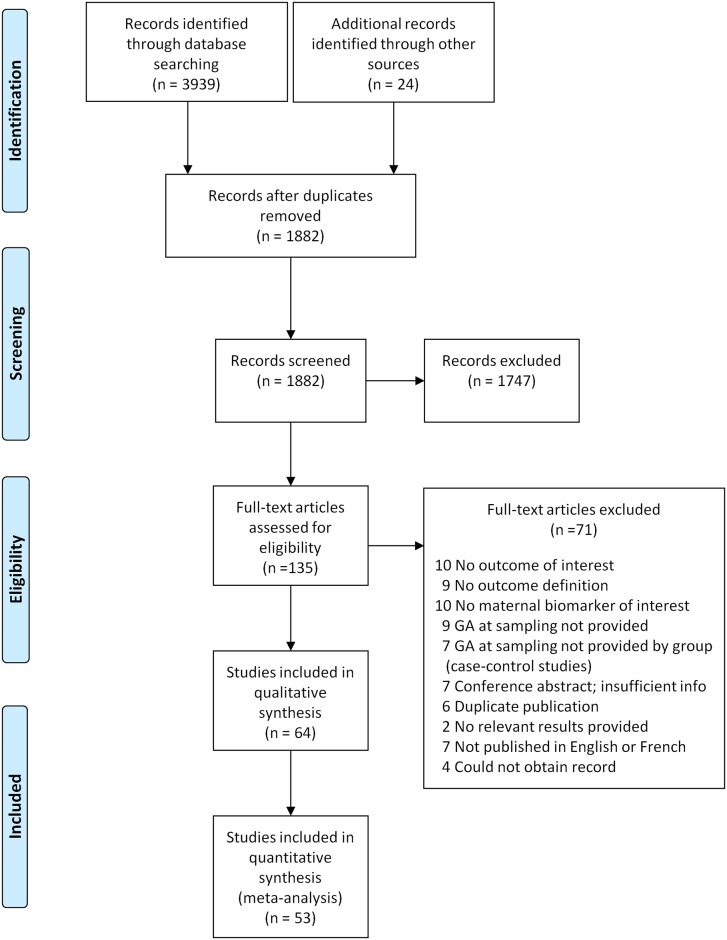
Flow diagram of study selection process.Figure adapted from: Moher D, Liberati A, Tetzlaff J, Altman DG, The PRISMA Group (2009). Preferred Reporting Items for Systematic Reviews and Meta-Analyses: The PRISMA Statement. PLoS Med 6(6): e1000097. doi:10.1371/journal.pmed1000097